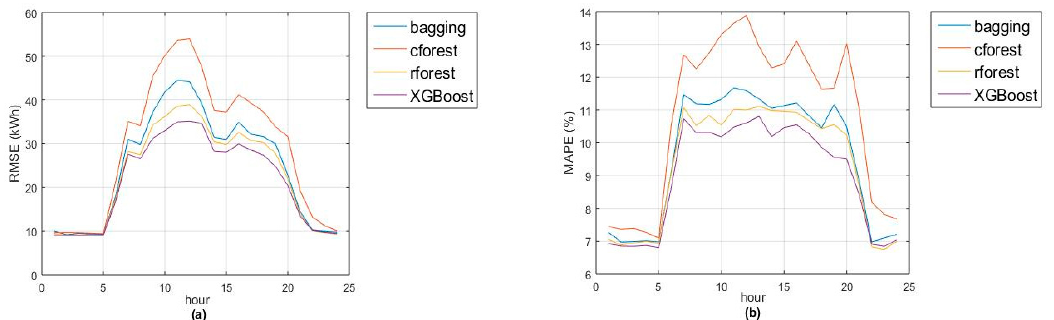
Figure 2. Goodness-of-fit measures for each ensemble method by hour of the day in 2016: ( a ) using RMSE (kWh); ( b ) using MAPE (%).